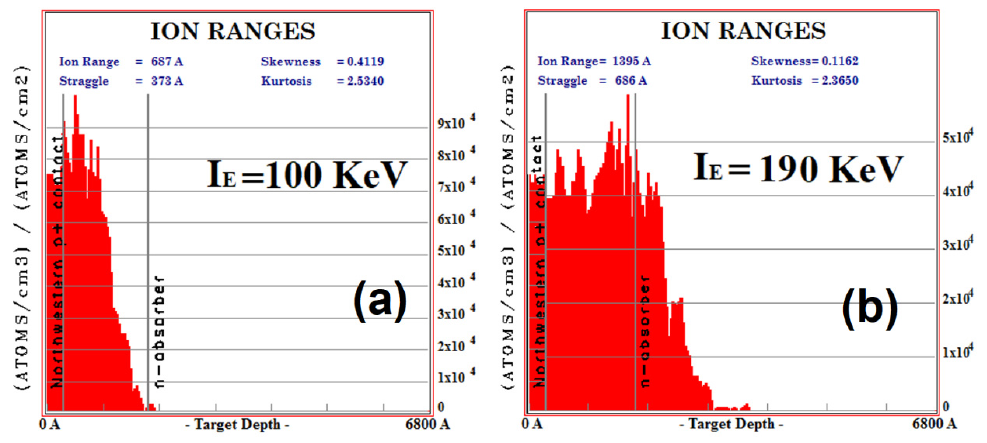
Figure 2. Simulation results performed using SRIM software for distribution of the Si ions in different depths of the target for various implantation energies: ( a ) I E = 100 keV, ( b ) I E = 190 keV.